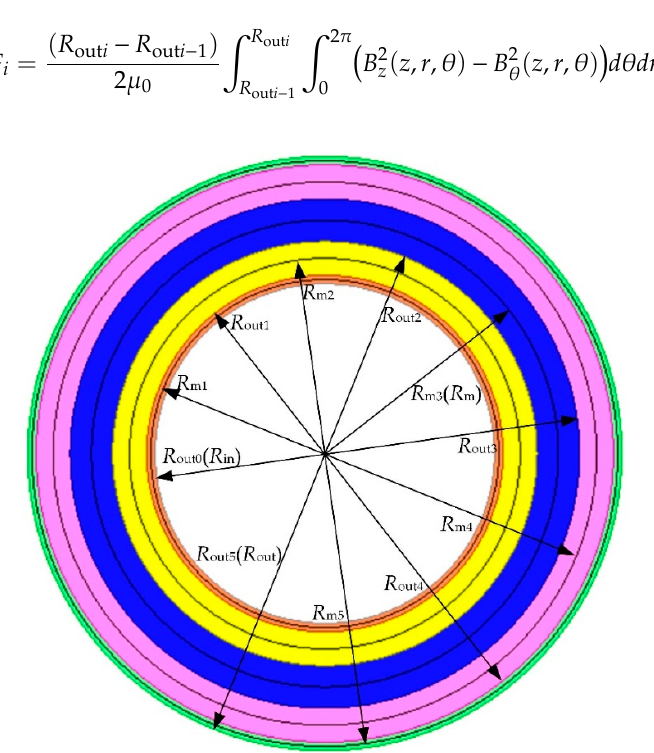
Figure 3. Each color represents a part of the LG. The torque and axial force generated by the five parts are superposed to be the torque and axial force generated by the entire HAMG, respectively. The 1st part is from R out0 = 40 mm to R out1 = 42 mm, the 2nd part is from R out1 = 42 mm to R out2 = 50 mm, the 3rd part is from R out2 = 50 mm to R out3 = 60 mm, the 4th part is from R out3 = 60 mm to R out4 = 68 mm and the 5th part is from R out4 = 68 mm to R out5 = 70 mm.